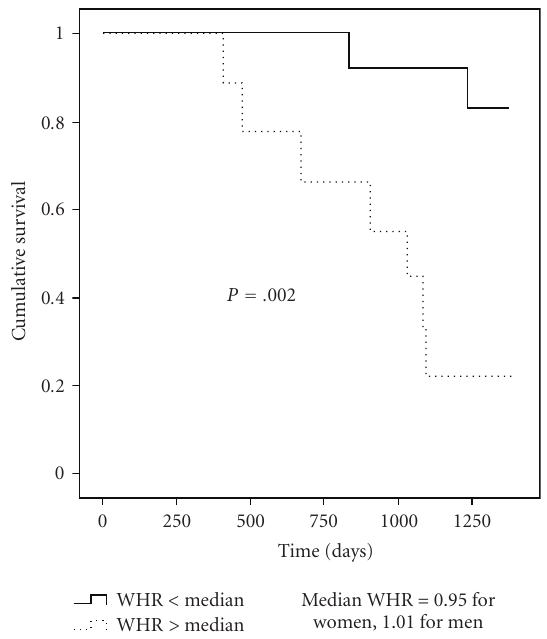
Figure 1: Kaplan-Meier survival curves for patients above and below the gender-specific median for WHR.